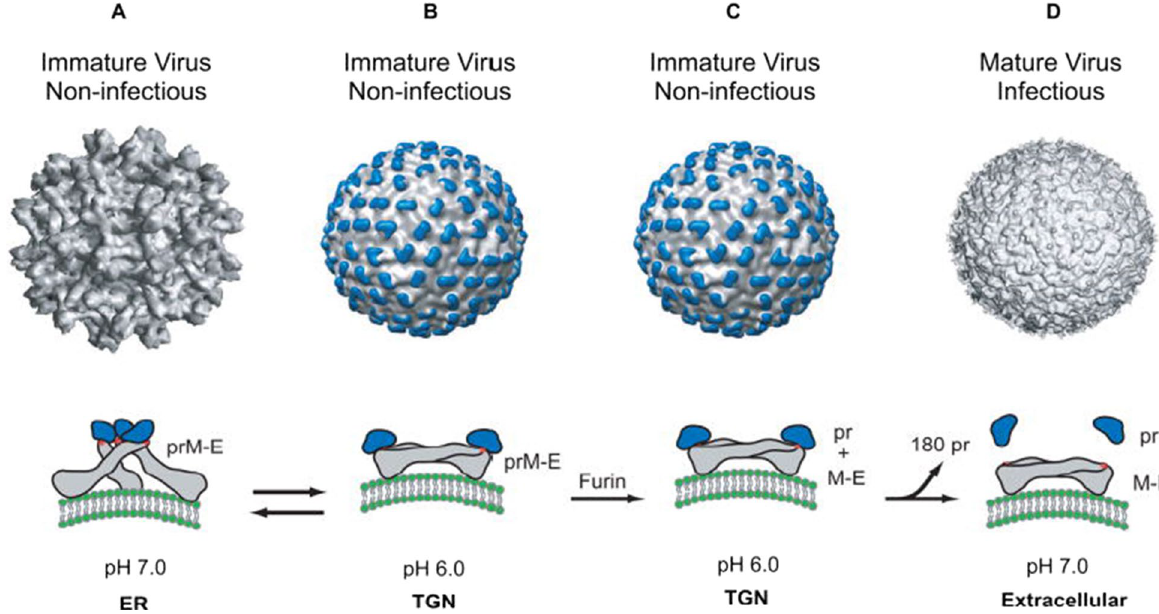
Fig. 1 Structure of the dengue virion and conformations of the E